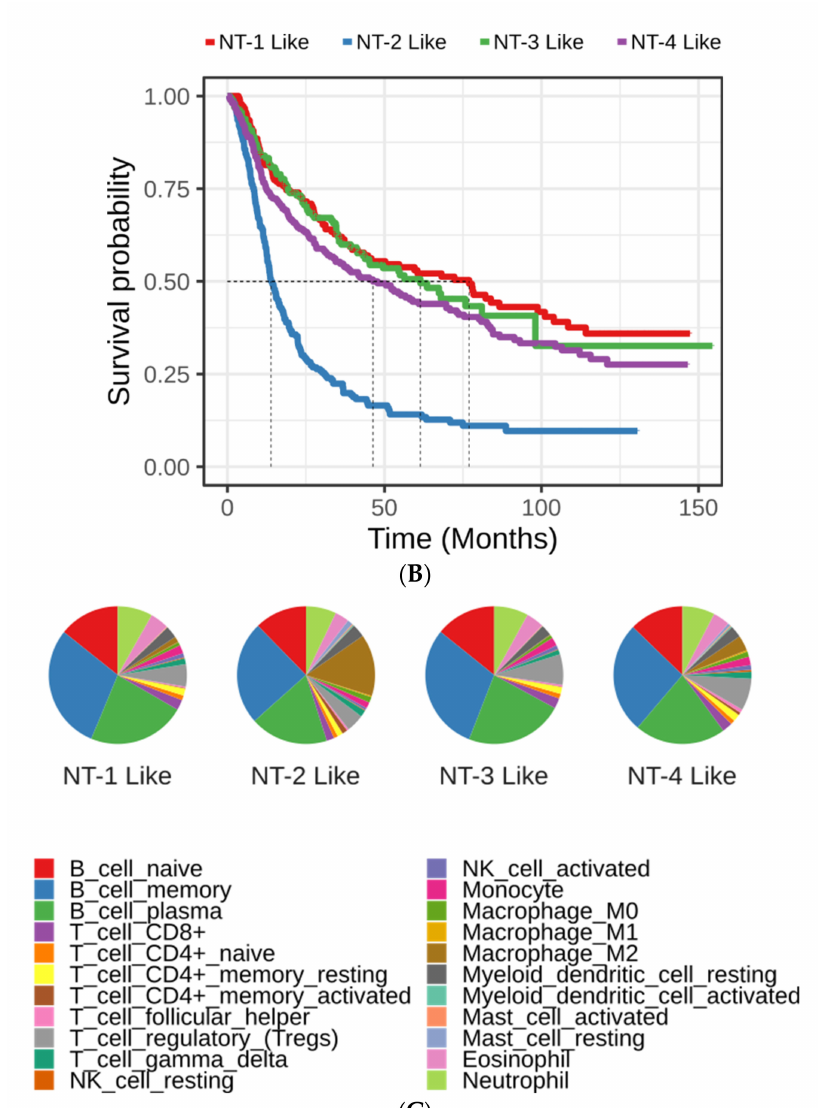
Figure 8. ( A ) Distribution of glioma molecular alterations in CGGA neurotransmission-related glioma clusters. The four clusters were generated by hierarchical unsupervised clustering using Pearson correlation (glioma samples in column) and Minkowski distance (genes in rows). Ward.D2 clustering method was selected for this clustering. ( B ) Kaplan–Meier survival curves associated with the CGGA NT-1-4 like glioma clusters. Red, blue, green and purple represent the various CGGA NT-1-4-like glioma clusters, respectively. Cluster-to-cluster significance was calculated using the log-rank test. ( C ) Immune cell type inference for NT-1-4 like gliomas using CIBERSORT. CIBERSORT infers the immune cell fraction relative to the total immune cell